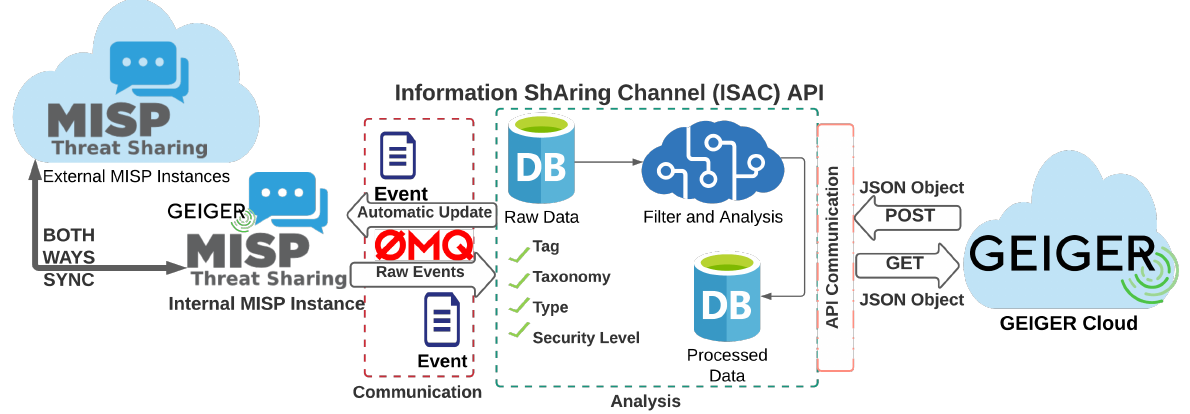
Figure 3. Incoming MISP data processed by the GEIGER information sharing channel and stored in the GEIGER cloud